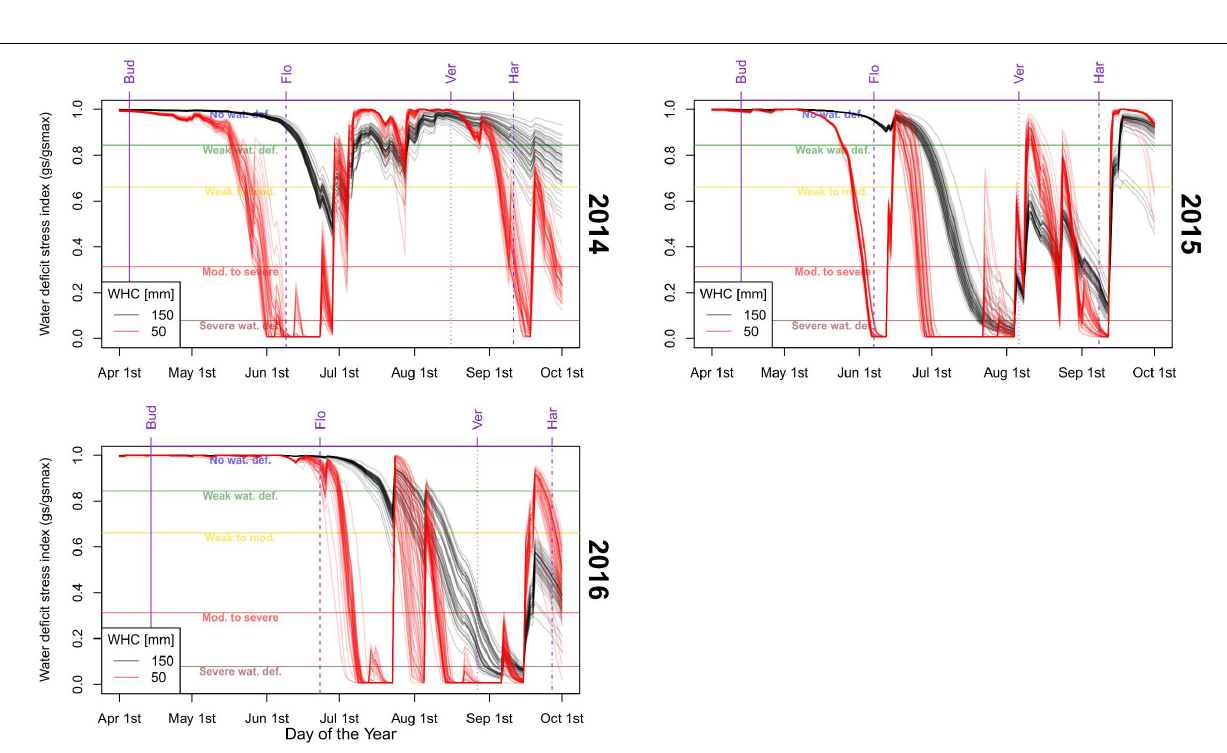
Frontiers in Environmental Science |